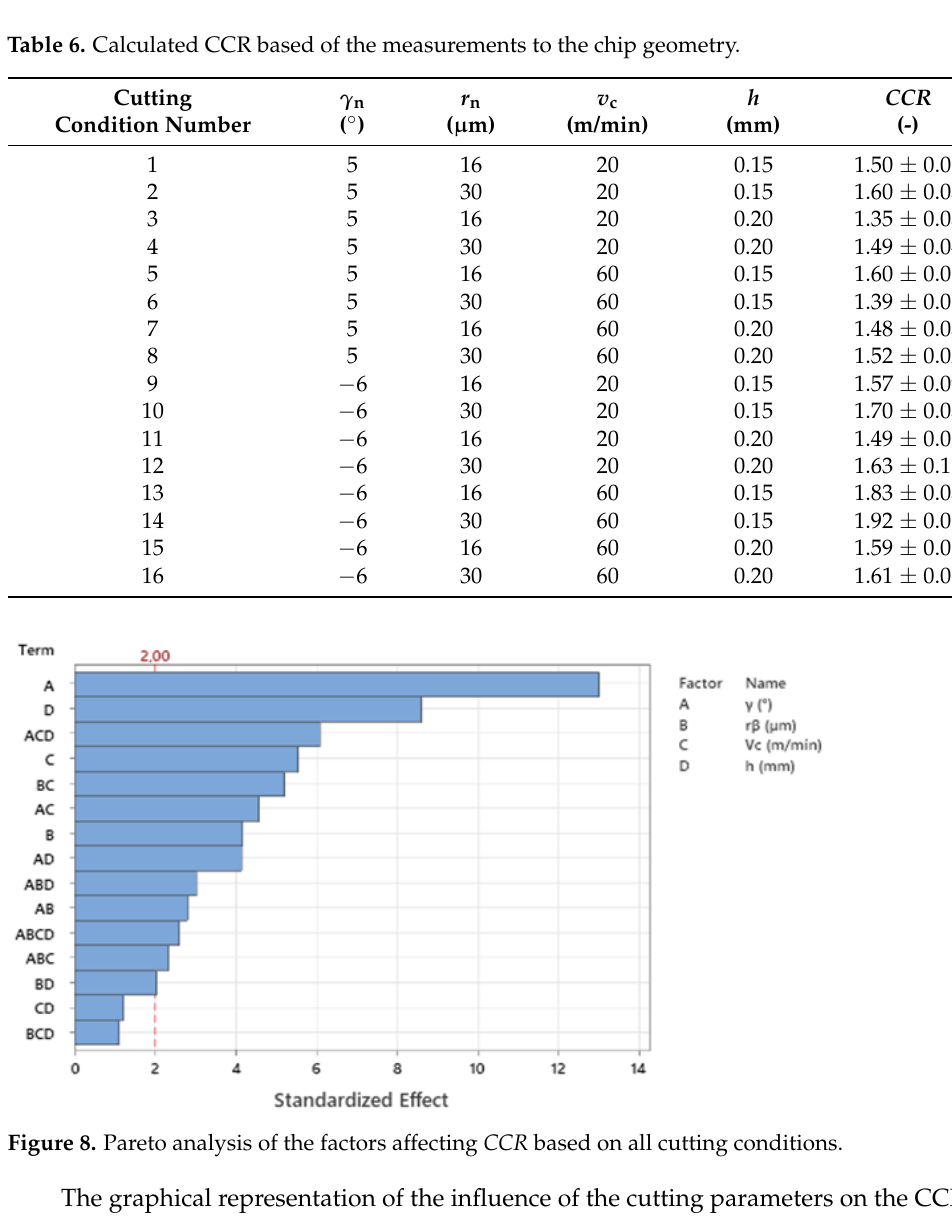
Figure 9. Influence of the cutting parameters on the CCR based on all cutting conditions.